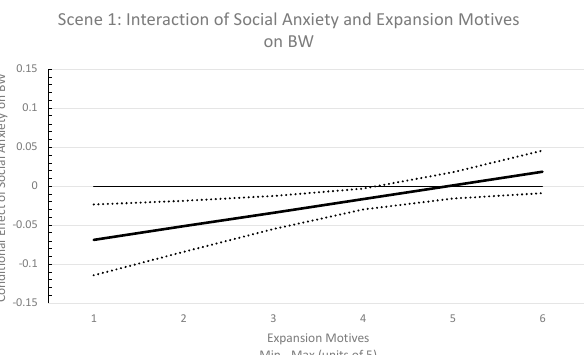
Scene 1: Interaction of Social Anxiety and Expansion Motives on BW